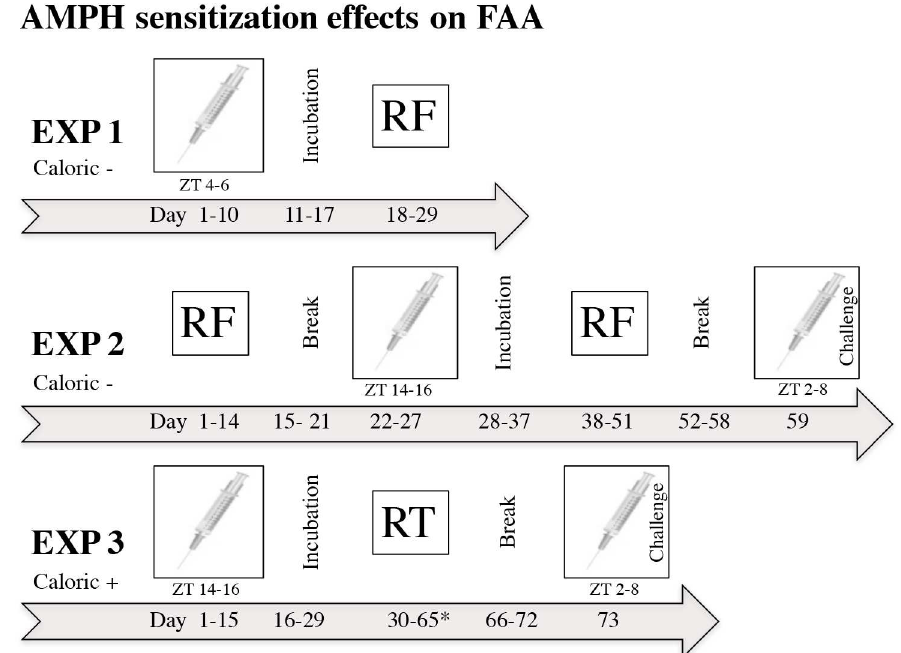
Fig 2. Exps 1–3: protocols for evaluating effectsof AMPH sensitization on FAA. Experiments 1 and 3, use a betweengroups design to evaluateFAA in AMPH pretreatedrats and controls, and experiment2 uses a within group design to evaluateFAA before and after AMPH sensitization. Caloricrestriction (-) or surplus (+) indicatesthe use of RF or RT, respectively,in eachexperiment. Timelines for AMPH sensitizationand scheduled feedingare describedbelow.Exp 1: rats were subjected to AMPH sensitization followedby an incubationperiodand RF. Exp 2: rats wereplacedon RF before AMPH sensitization (RF-before), followedby a break, and then dividedinto 2 groups:non-handled controlor AMPH for AMPH sensitization, followedagainby a break (incubation)andRF (RF-after). Rats were next returnedto free access feedingand then challenged with a low dose of AMPH to see whether differences in LS were present between AMPH-pretreatedrats and controlssubjectedto RF. The day prior to the AMPH challenge (day 58), a habituationrun usinga saline injectionwas conducted. Exp 3: rats were dividedinto 2 groups andsubjectedto AMPH sensitization followed by an incubation periodprior to beingplacedon RT for 5 weeks. * Duringweek 5 (days 59–65)the lights remained off (DD). As in experiment 2, followinga break rats werechallenged with AMPH to see whether differences in LS were present betweenAMPH pretreatedrats and controlssubjectedto circadianfeedingwith no caloric restriction (RT). Both AMPH challenge tests (Exp 2 and 3) occurredduringthe lights on phase betweenZT 2–8, consistent with time of previousFAA expression. Each AMPH sensitization protocolwas selectedbasedon the criteria that a prior study verifiedit to result in an increaseof extracellular DA in the striatum and/or enhanced locomotor